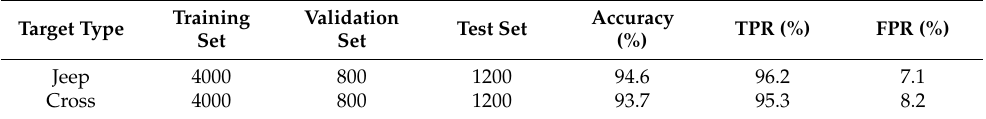
Table 1. Training and testing result of YOLOv4.